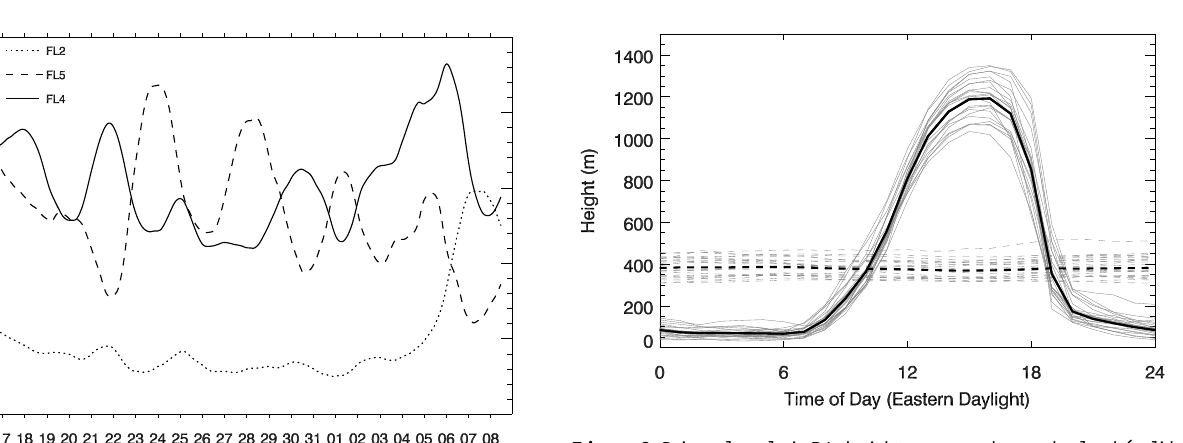
tracer in balance between continuous emission at the land surface